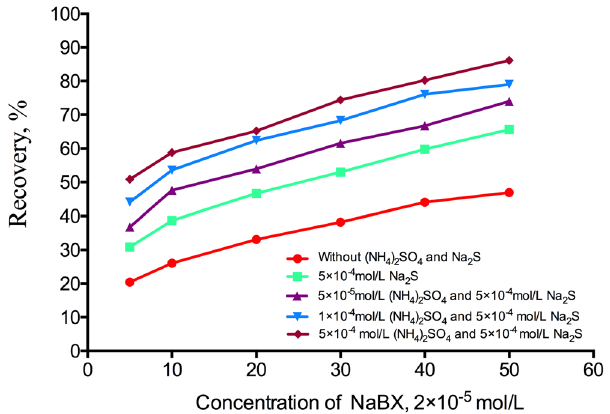
Figure 1. Flotation recovery of malachite as a function of NaBX concentration in the absence or presence of different concentrations of